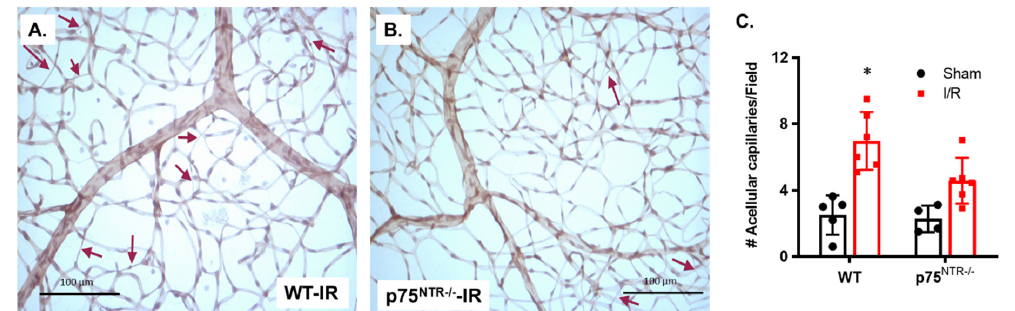
Figure 1. Deletion of p75 NTR reduced the development of acellular capillaries in ischemic retinas. ( A , B ) Representative trypsin-digested and PASH-stained retinas of WT and p75 NTR-/- mice subjected to I/R. Bright field imaging showed an increased number of acellular capillaries (red arrows) in WT that was attenuated in p75 NTR-/- mice (20x magnification. ( C ) Statistical analysis using two-way ANOVA showed significant impact of disease condition (ischemia) and gene deletion on the number of acellular capillaries. I/R significantly increased the number of acellular capillaries in WT retinas when compared to shams. This effect was ameliorated in retinas of p75 NTR-/- mice (*, significant using two-way ANOVA, n = 4–5).